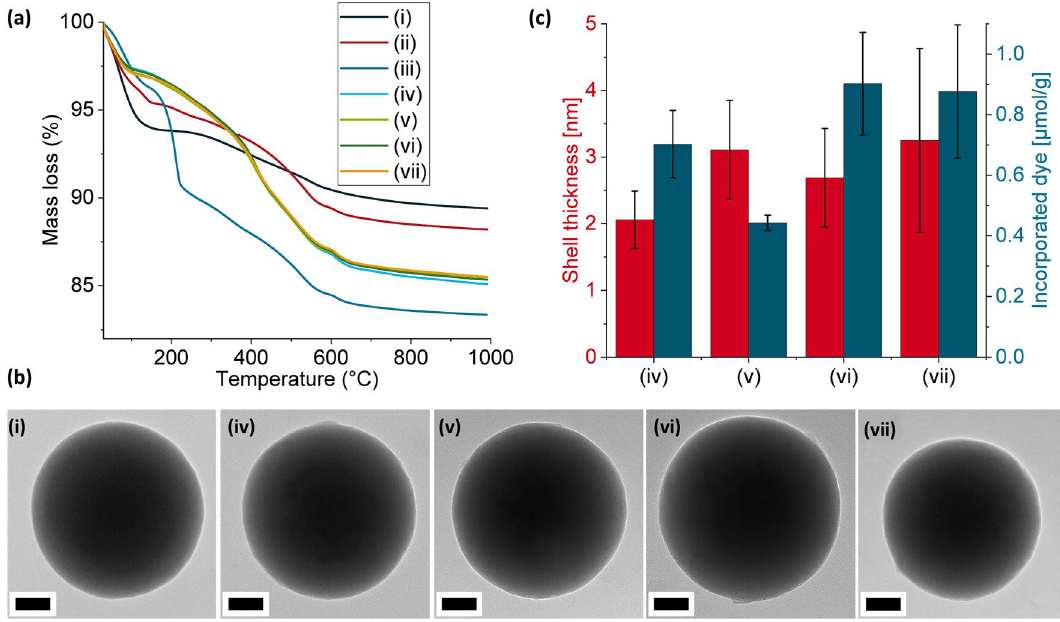
Figure 4. ( a ) TGA curves for (i) SiO 2 , (ii) APTES@SiO 2 , (iii) RAFT@SiO 2 , (iv) MIPTBA@SiO 2 , (v)